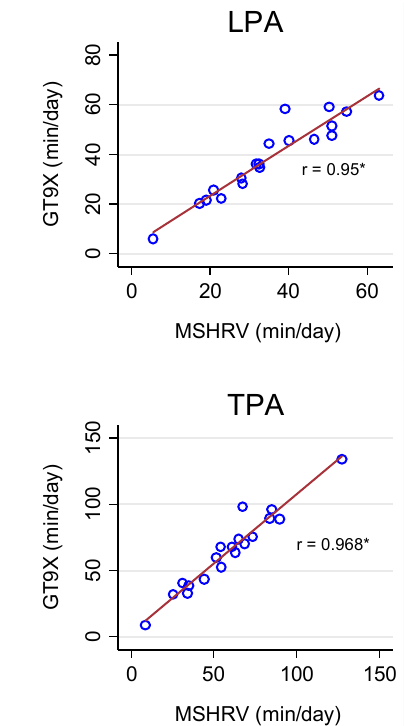
Figure 1. Pearson Correlations (r) for sedentary behavior and physical activity (PA) estimates between the GT9X and MotionSense HRV (MSHRV) under free-living conditions. SED: sedentary behavior; LPA: light PA; MVPA: moderate-to-vigorous PA; TPA: total PA; * p < 0.05.